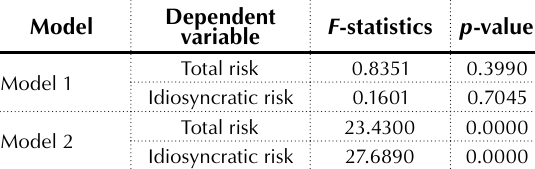
Table 6. Results of autocorrelation